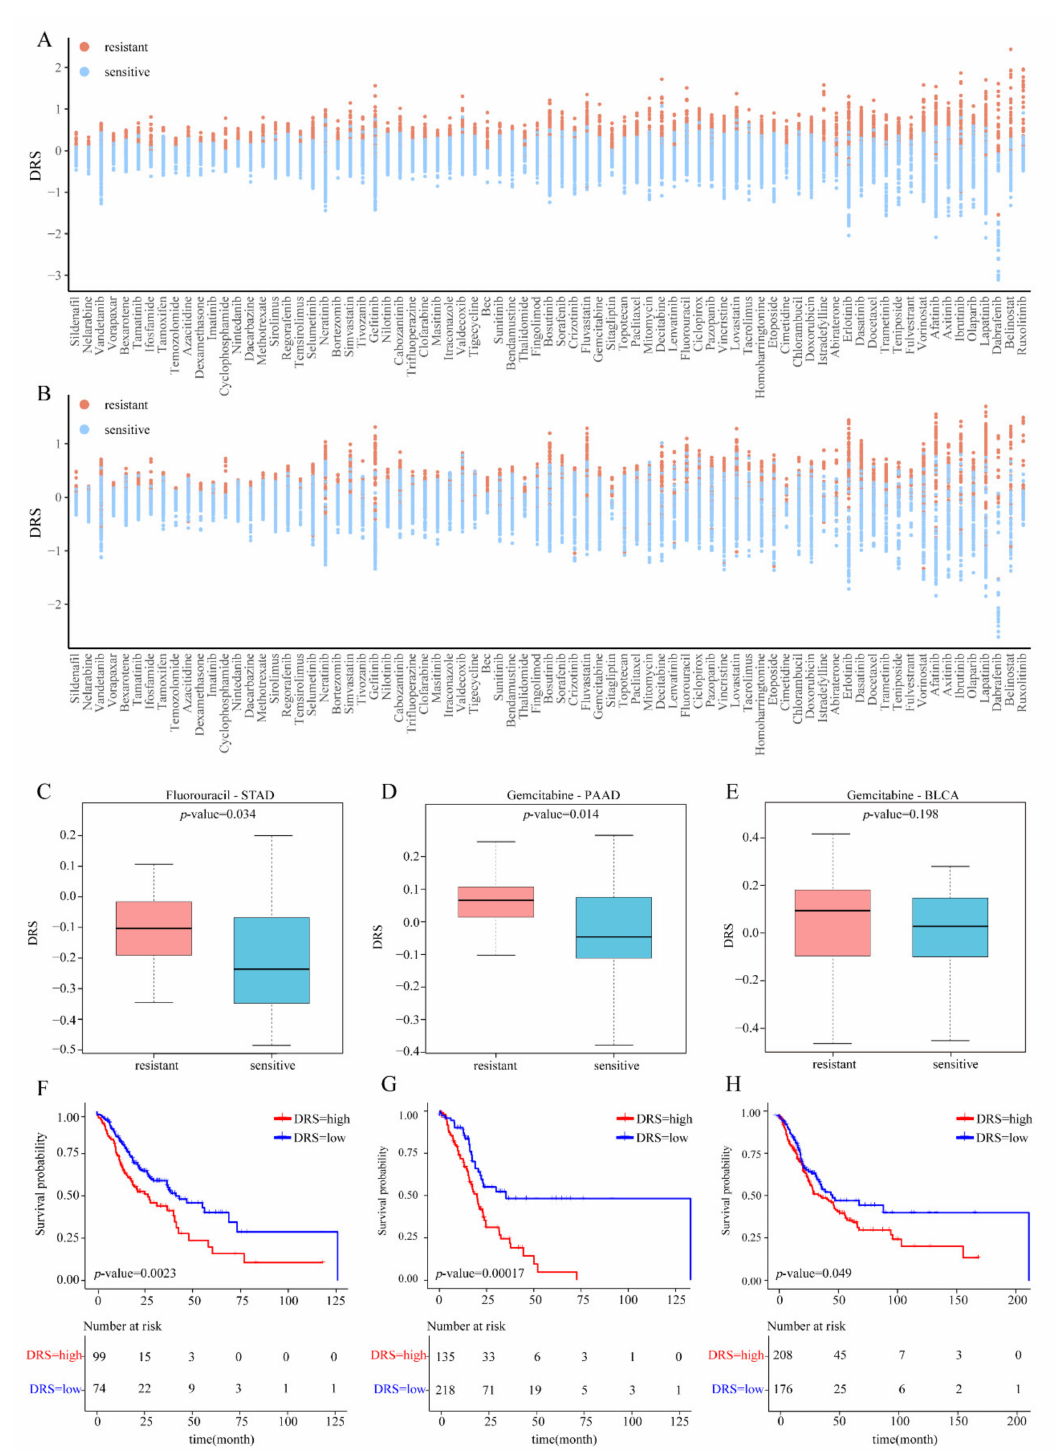
Figure 2. Validation of scDR. ( A ). The dot plot of DRSs for 77 FDA-approved drugs using the Discovery Cohort. The red dots represent resistant cell lines, and the blue dots represent sensitive cell lines. The x -axis represents 77 FDA-approved drugs. The y -axis shows the DRS . ( B ). External validation using Validation Cohort I. The dot plot of DRSs for 77 FDA-approved drugs. The red dots represent resistant cell lines, and the blue dots represent sensitive cell lines. The x -axis represents 77 FDA-approved drugs. The y -axis shows the DRS . ( C – H ). Validation using Validation Cohort II. Box plot of DRSs for resistant and sensitive samples in three drug-cancer pairs ( C – E ). Kaplan–Meier curves for patients with different cancers (STAD, PAAD, and BLCA) according to the mean value of DRSs ( F – H